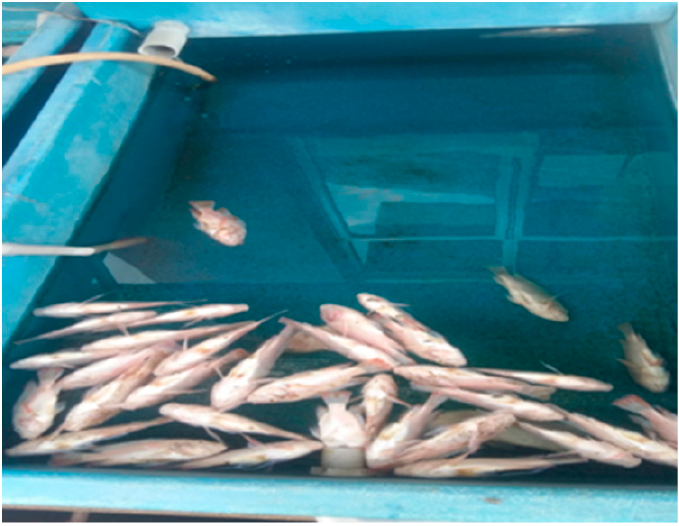
Figure 5. All Red hybrid tilapia died in control Group Cx after the challenged at 4-wpv.